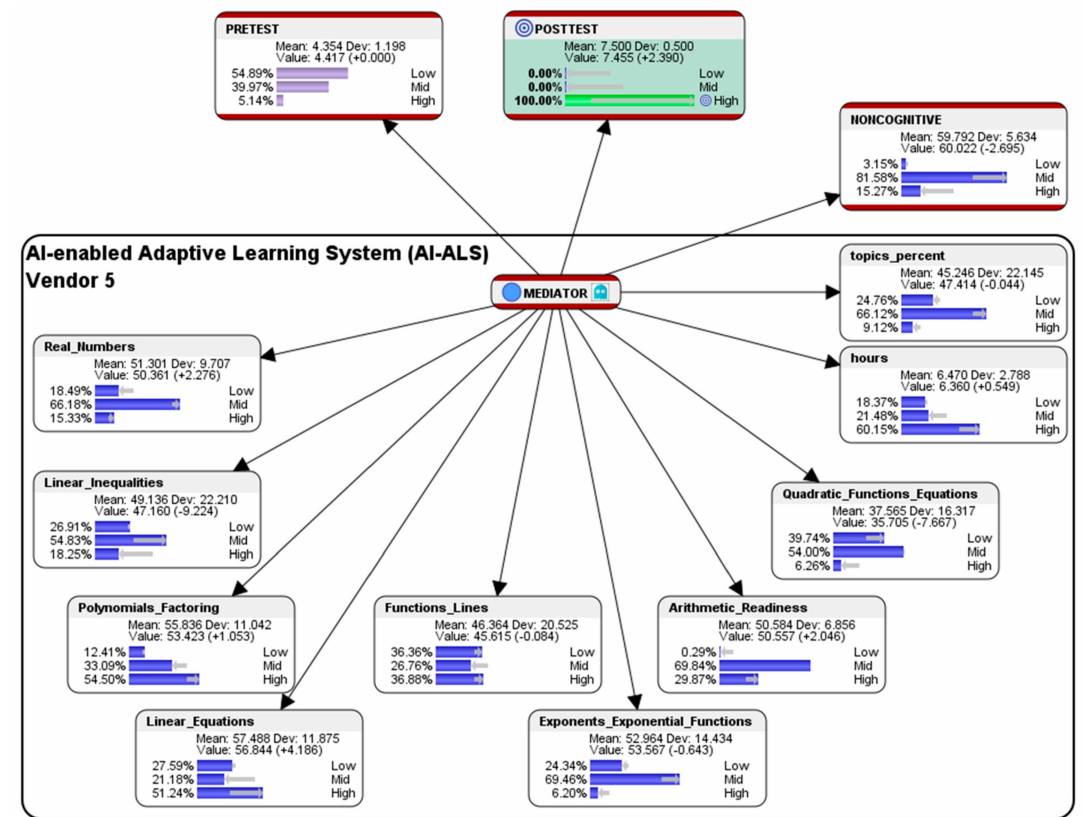
Figure 20. Simulation of counterfactual results for 100% of the students who had used Vendor 5 (cid:48) s AI-ALS to score at the high-level in the post-test. Grey arrows recommended whether there should be an increase (pointing to the right), or a decrease (pointing to the left) in each respective mathematics topic’s score-clusters for Low-, Mid-, and